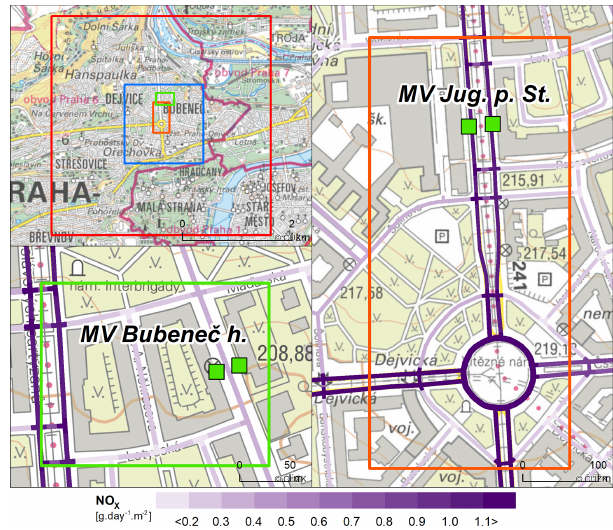
Figure 3. Nitrogen oxides (NO x ) emitted by cars along their tra- jectories in selected locations in Dejvice, Prague. Emissions were summarized in grams per day per square metre (gd − 1 m − 2 ) and disaggregated to 1h time steps. The red and blue squares in the top left map indicate the extent of the parent and child PALM domains respectively. The orange and green rectangles show the locations of the expanded views given in the right and lower left panels. The ex- panded views show the air quality measurement locations (MV) in Terronská Street – Bubeneˇc house (lower left) and Jugoslávských partyzán˚u Street (right) using green squares. The base map of the Czech Republic at 1 : 10000 for the city of Prague was provided by the Czech Office for Surveying, Mapping and Cadastre (ˇCÚZK,